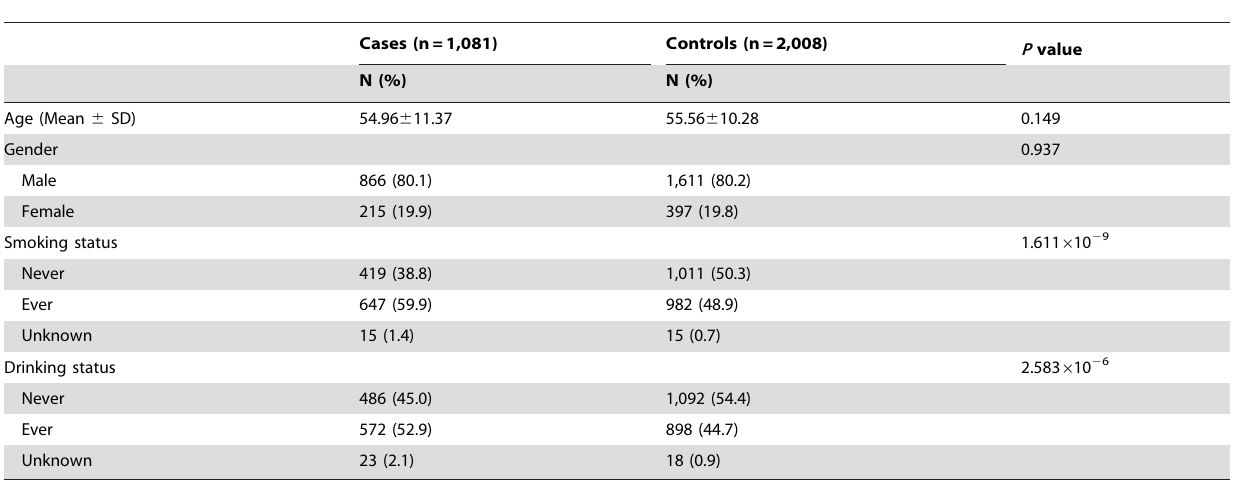
Table 1. Distributions of characteristics among HCC patients and controls in our